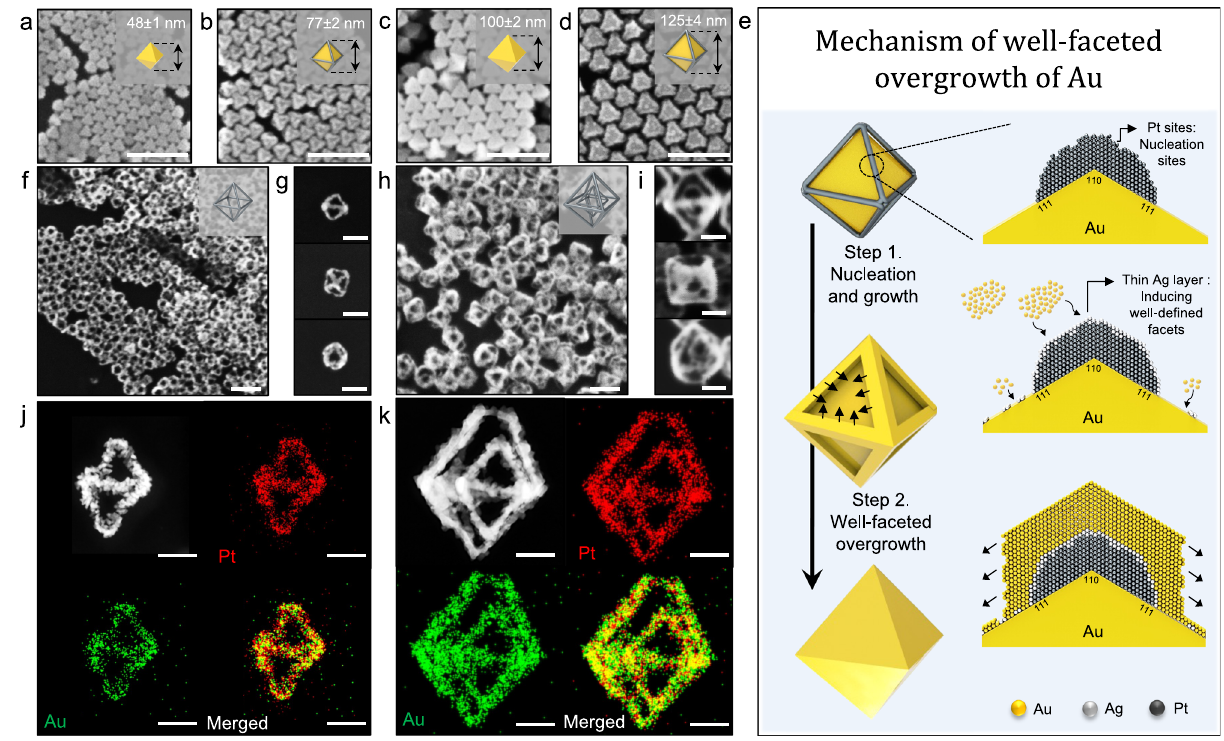
Fig. 2 | Representative schematic illustration for mechanism of well-faceted overgrowth of Au, and morphology evolution from 1 st to 2 nd nanoframes. SEM images of a 1 st -Au-O-NPs, b 1 st -Au@Pt-O-NPs, c 2 nd -Au-O-NPs, and d 2 nd -Au@Pt-O- NPs,scalebar=200nm. e Schematicillustrationthatshowsthemechanismofwell-